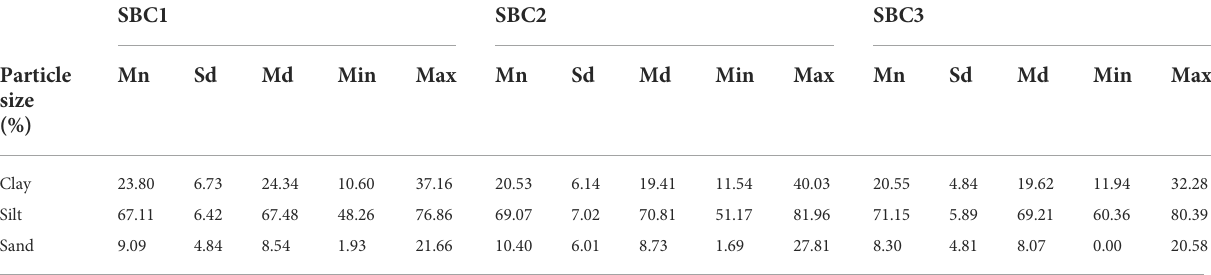
TABLE 4 Basic statistics for the particle size for the three different sub-catchments (SBC1, SBC2, and SBC3). SBC1 SBC2 SBC3 Particle